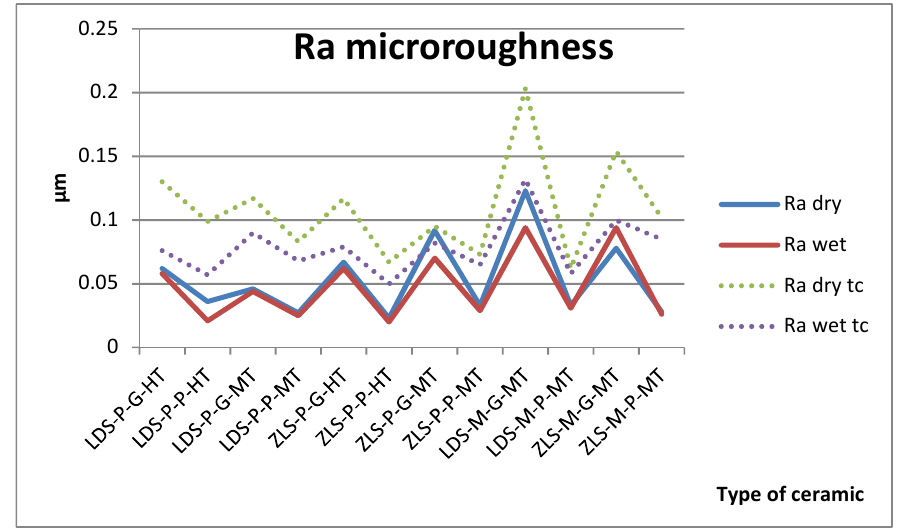
Figure 1. Arithmetic average roughness (Ra) microroughness values for all tested samples, dry and wet, before and after thermal cycling (tc).